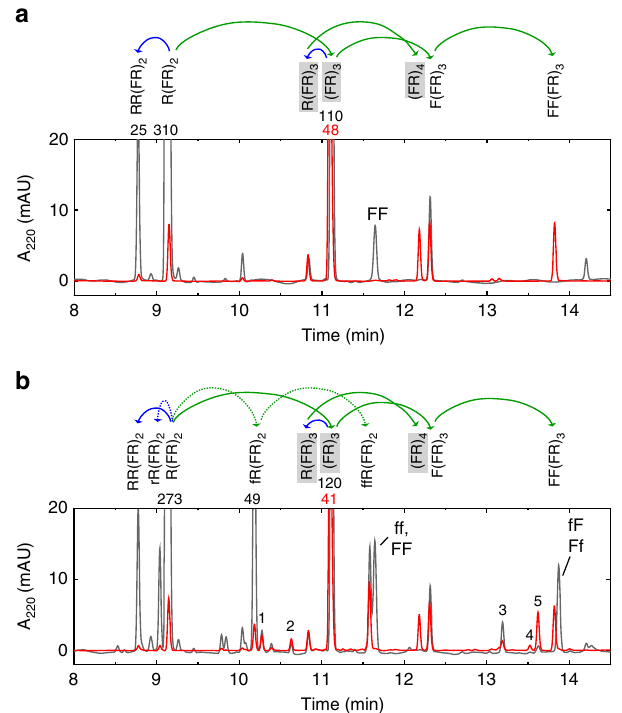
Fig. 4 Sequence-speci fi c and stereospeci fi c, consecutive triple addition reactions with the R(FR) 2 /(FE) 4 mixture. Reverse-phase HPLC chromatograms of the addition reactions of a mixture of arginine and phenylalanine ( a ), and a mixture of DL-arginine and DL-phenylalanine ( b ) with substrate R(FR) 2 , in presence (red) or absence (black) of template (FE) 4 . The maximum absorbance of the peaks that go off scale are listed above the peaks and the overlaid chromatograms have been scaled to represent the same amount of the total reaction. The substrate and template concentration was 100 μ M, and amino acids were all at 200 μ M of each enantiomer. The sequential additions of amino acids are indicated by the curved arrows: green for phenylalanine and blue for arginine, dotted lines are for D-enantiomers and lower case letters indicate the positions of D-residues. The isotactic and sequence-speci fi c products are highlighted in gray. The labeled products were identi fi ed by mass spectrometry and control reactions with just D-enantiomers. The numbered products, identi fi ed only by mass spectrometry (sequence and stereochemistry